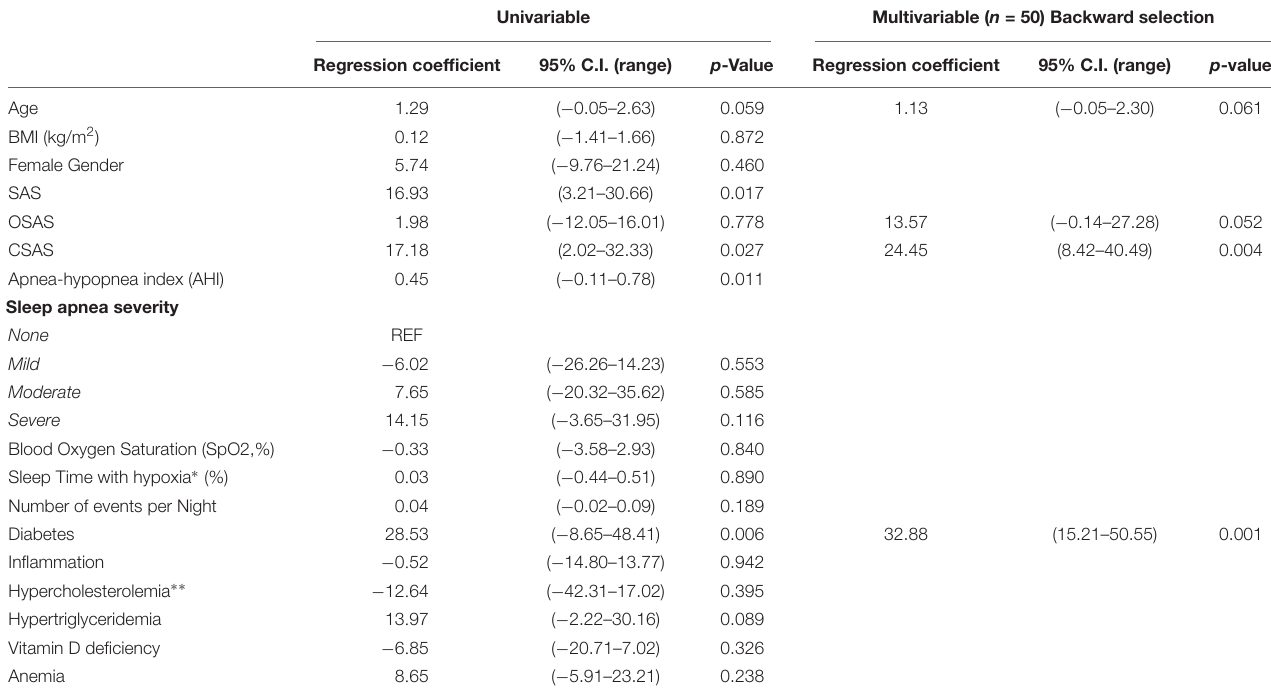
TABLE 8 | Uni- and Multi-variable regression to identify factors associated with the Stroop Interference Test (delay, s).